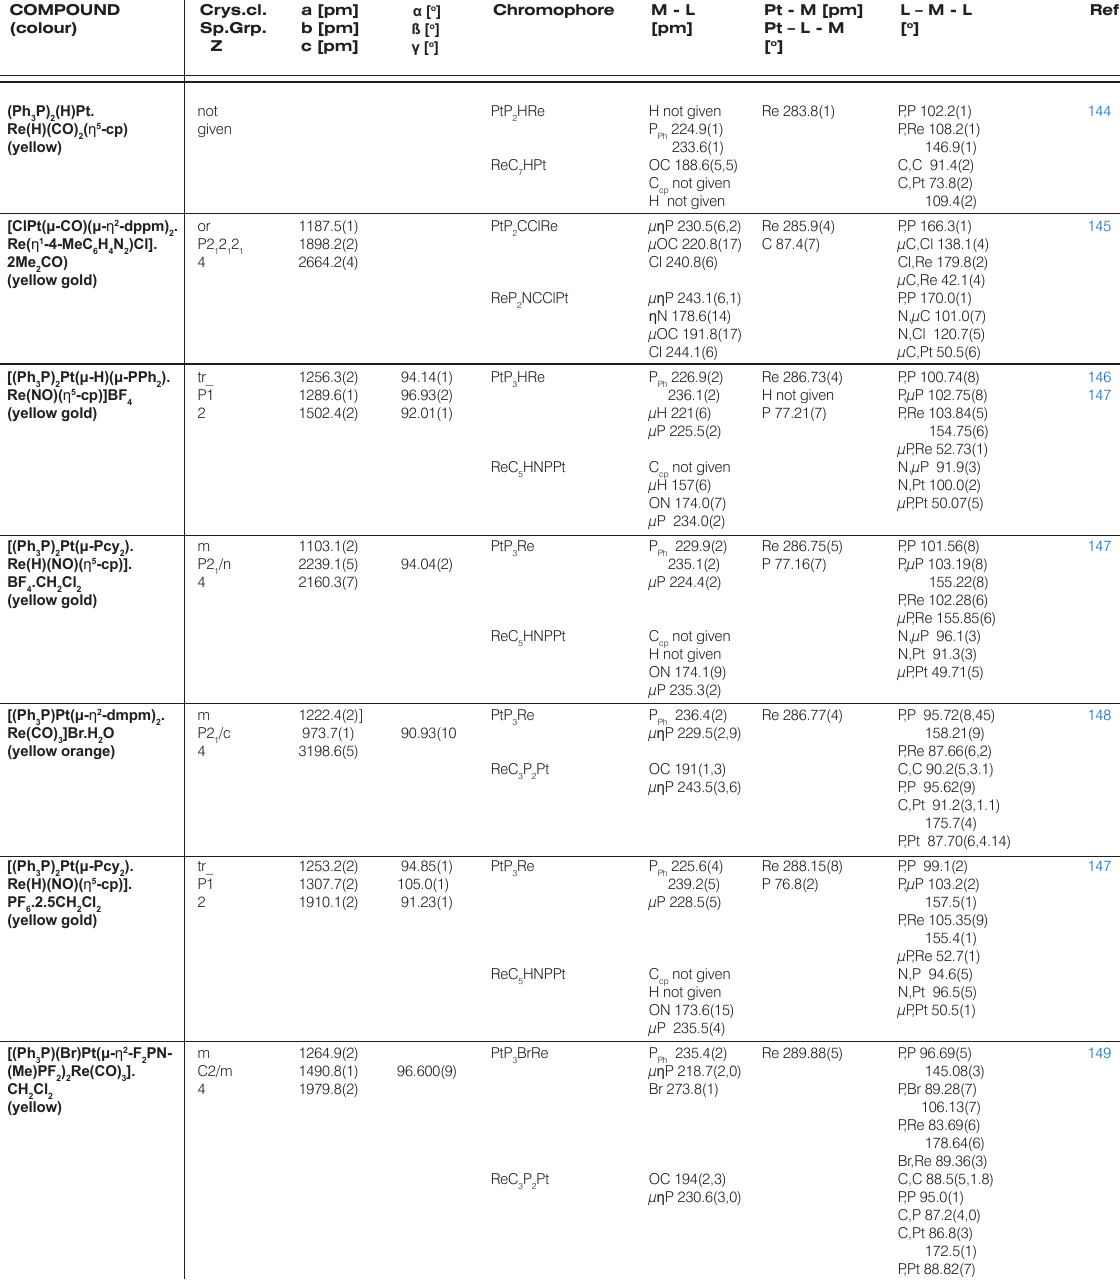
Footnotes: a Where more than one chemically equivalent distance or angle is present, the mean value is tabulated. The first number in parenthesis is the e.s.d., and the second is the maximum deviation from the mean. b The chemical identity of the coordinated atom or ligand is specified in these columns. c Five member metallocyclic by μ-H and μ-CO ligands with Pt-C-Mn bridge angle of the (Ph